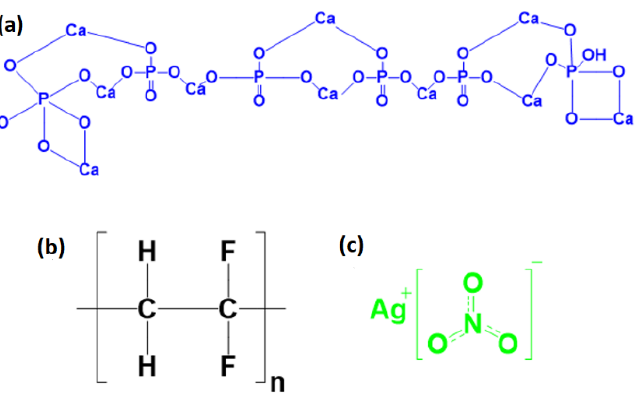
Figure 1. The chemical structures of compositions ( a ) HA, ( b ) PVDF, and ( c ) AgNO 3.